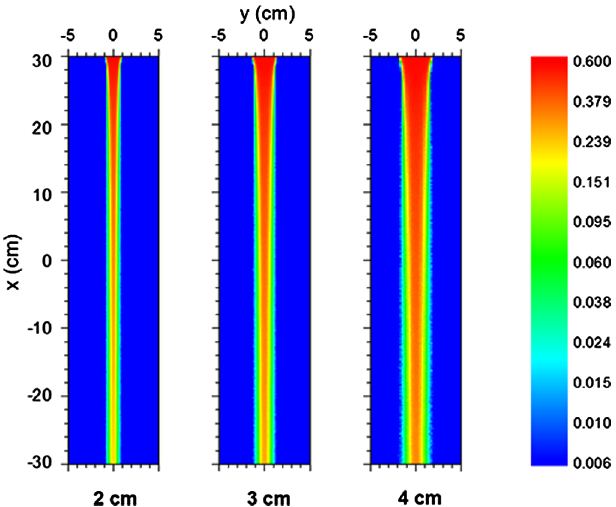
FIG. 8. Magnetic field profile distribution on axis along the field tapering section for the simulations for the NF and